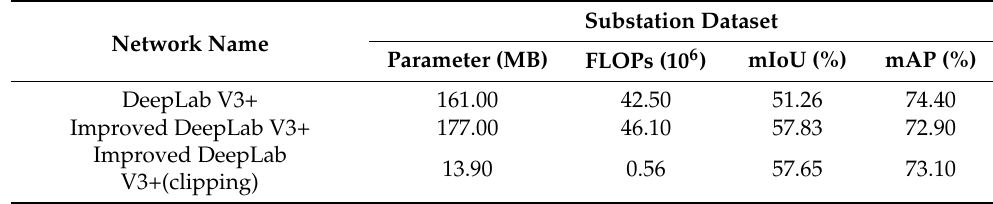
Table 4. MAP and mIoU test results by different network.